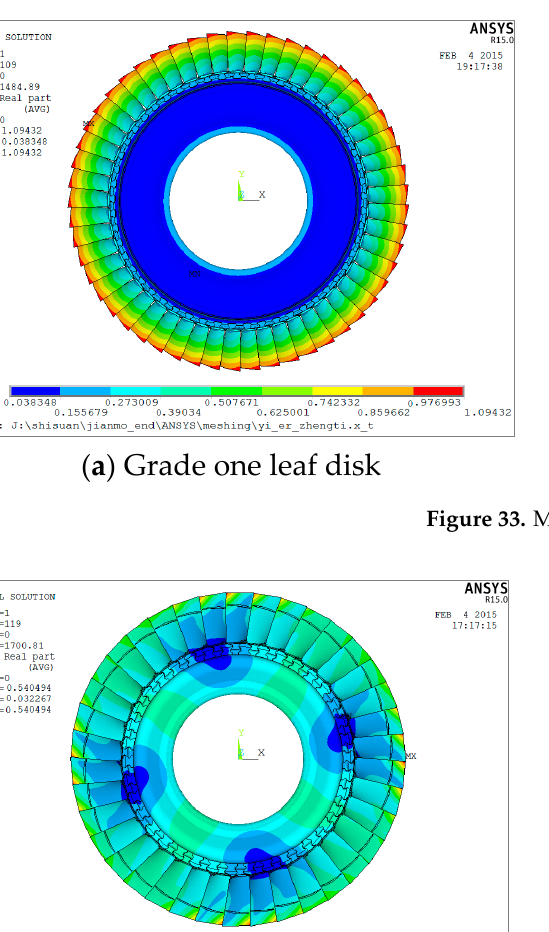
Figure 32. Mode 105.